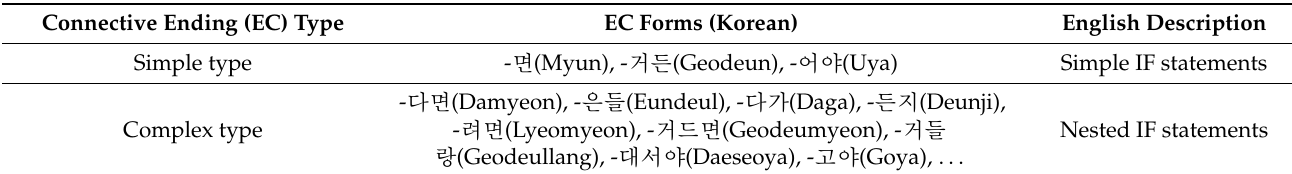
Table 2. Part of Connective ending (EC) types [8] in the Korean language. Table 3. Part of Condition types [8] in the Korean language